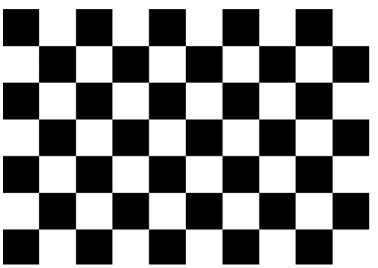
Figure 3. Black and white checkerboard calibration plate.